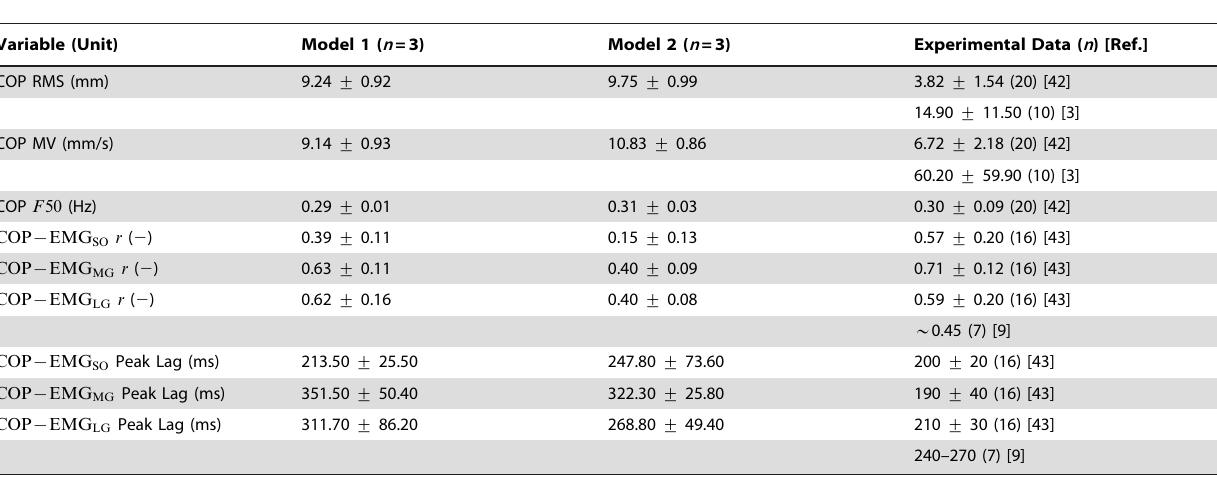
Model 1 is the postural control model without reciprocal inhibition, whereas Model 2 is the complete postural control model (see Methods for details concerning model structures). Data are expressed as Mean + Standard Deviation. F 50 is defined as the frequency at which 50% of the total power of the COP is confined (see Data Analysis). Values of r were measured as the peak values of the cross-correlation functions between COP and the EMGs of the Triceps Surae (TS) muscles (i.e., SO, MG, and LG). Data from [9,42,43] were obtained from healthy young subjects standing on a stable surface without visual feedback, while [3] provided data from vestibular loss patients standing on a stable surface without visual feedback.